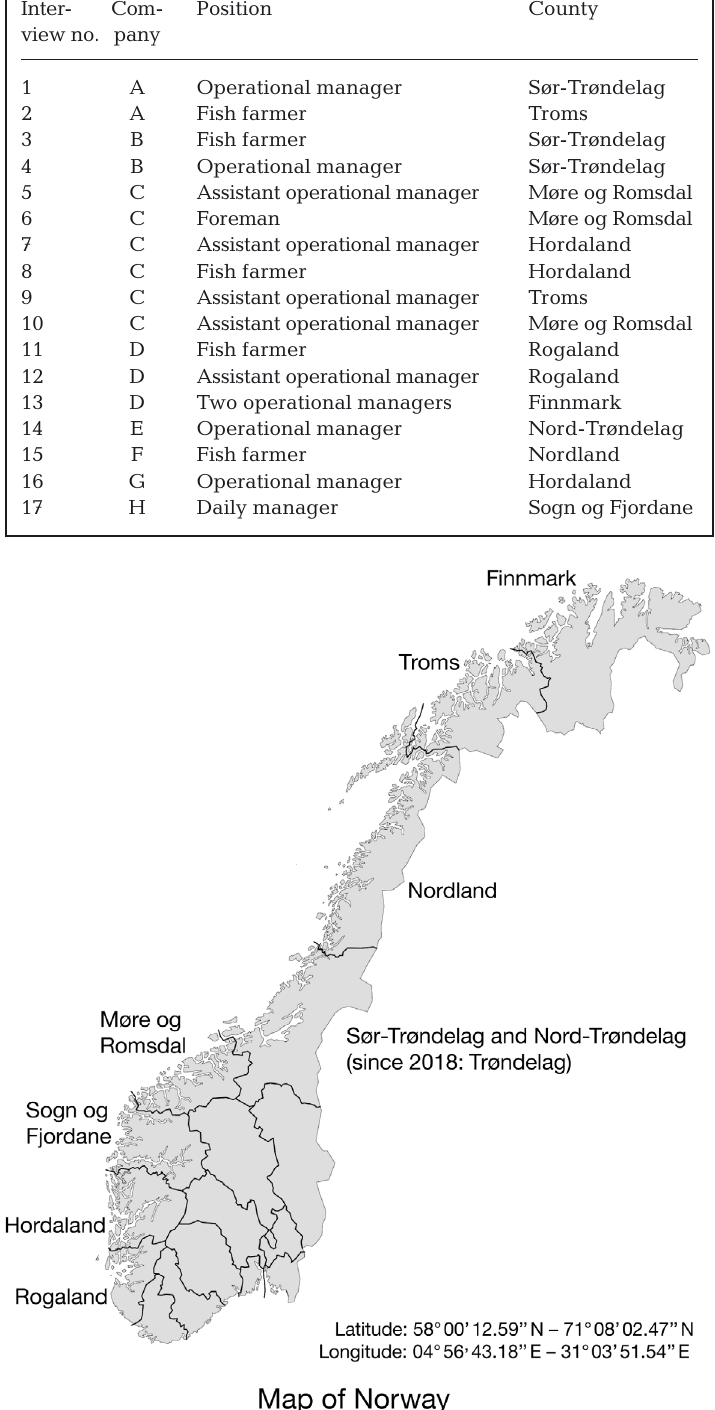
Fig. 1. Geographical location (counties) of the 8 Atlantic salmon fish farms where the interviewees worked (source: